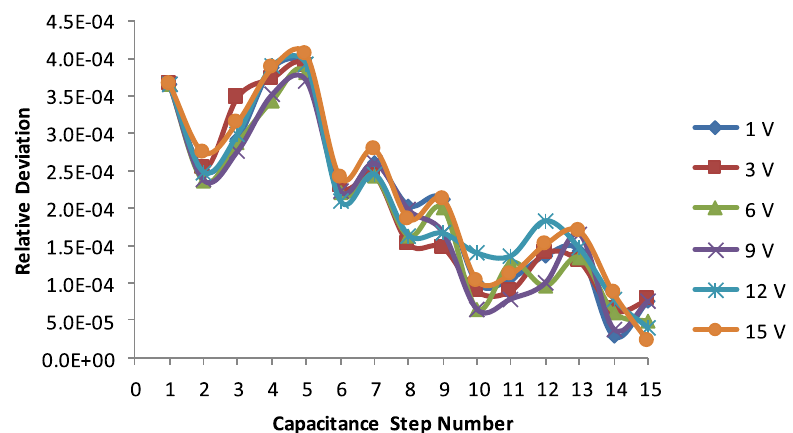
Fig. 8. Relative deviation of the output capacitance steps at different voltages and